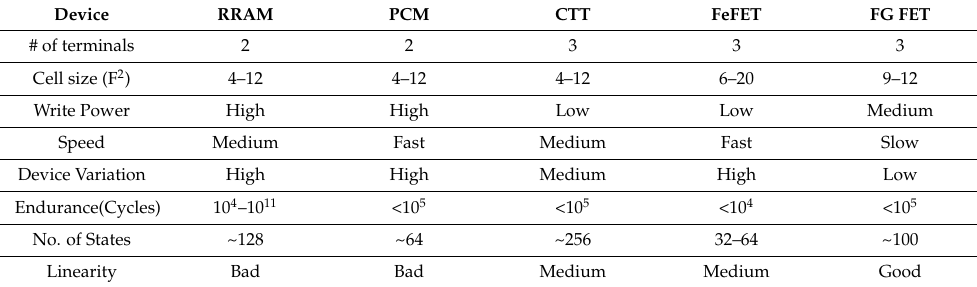
Table 2. Characteristics of the candidates for neuromorphic cell